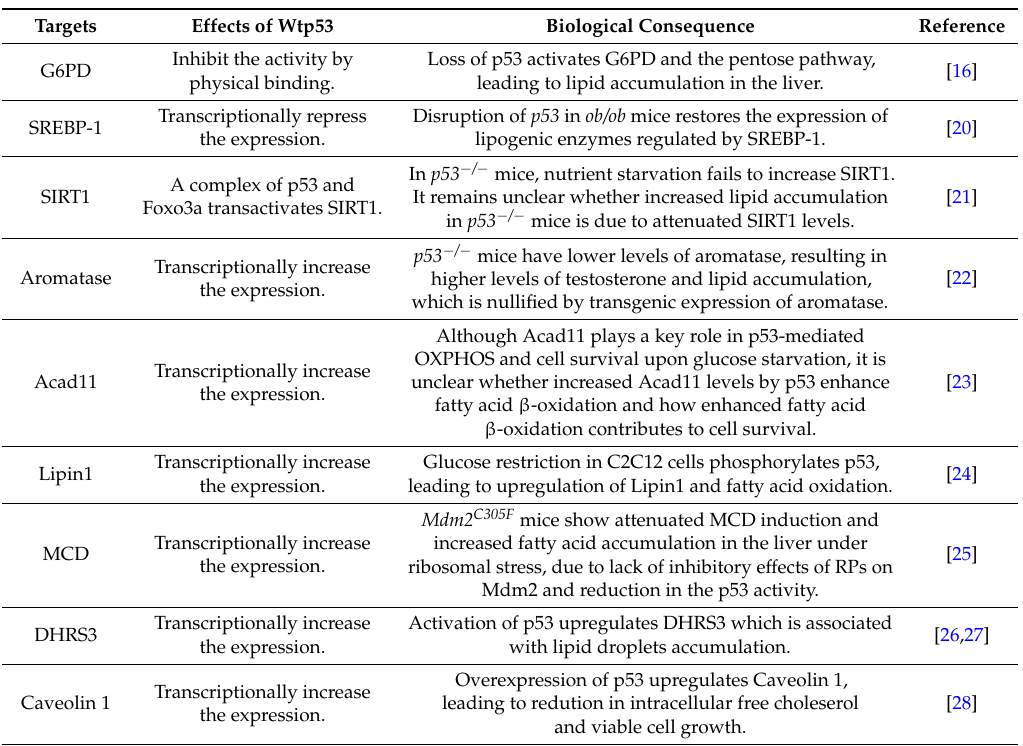
Table 1. Targets of wild-type p53 in lipid